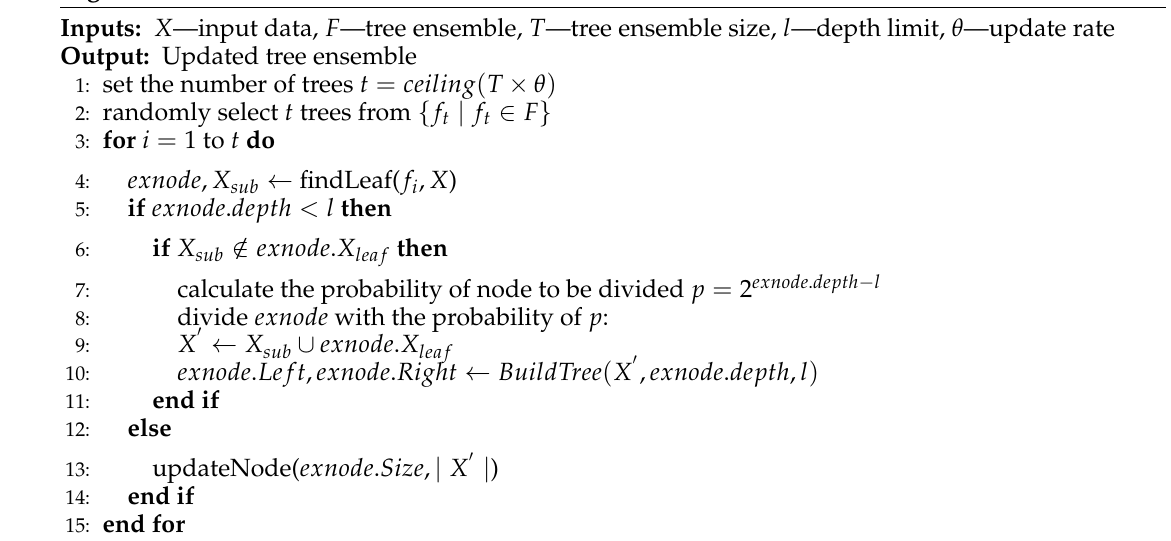
Algorithm 2 Online Growth of